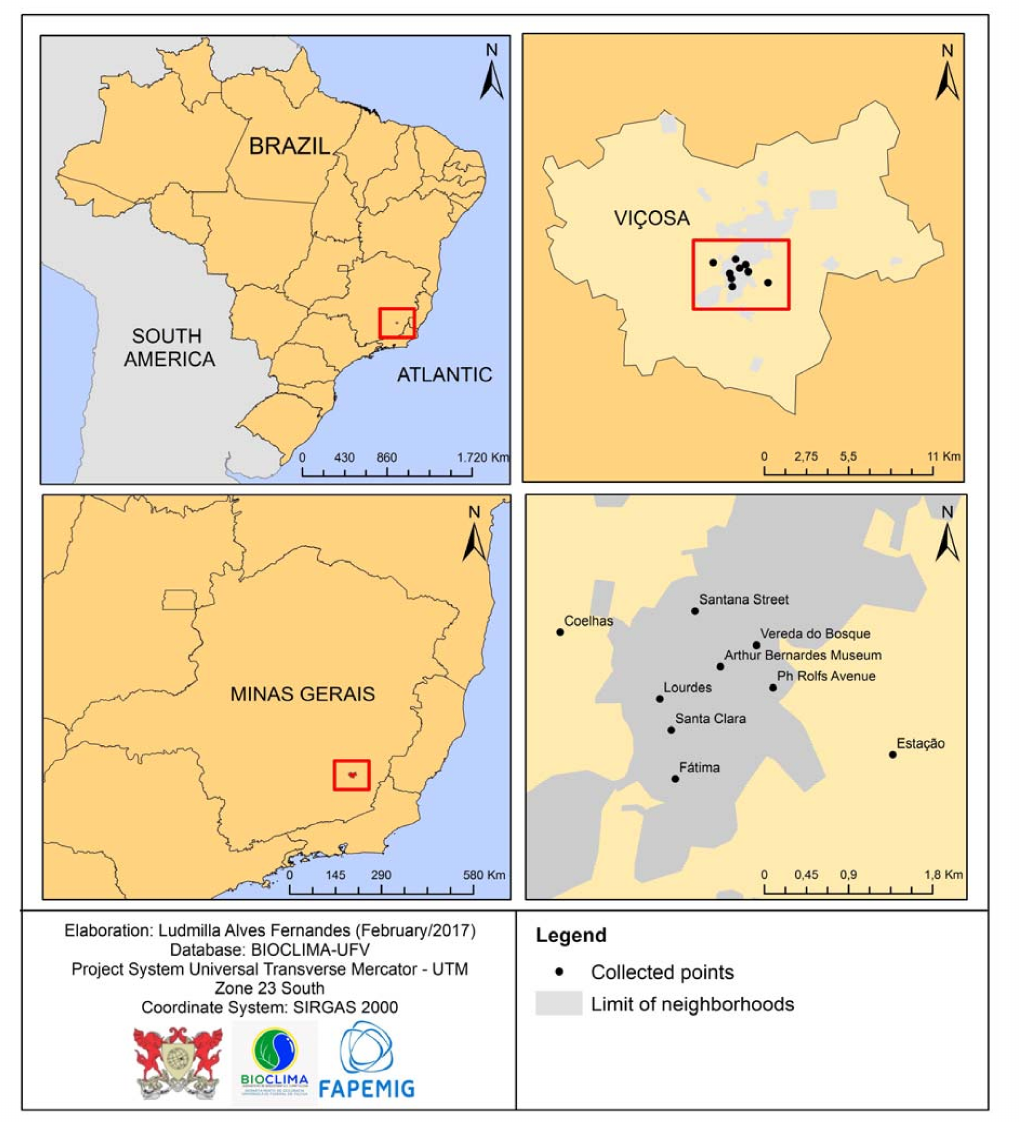
Figure 1. Localization map of collected points in the municipality of Viçosa (MG). Data source: